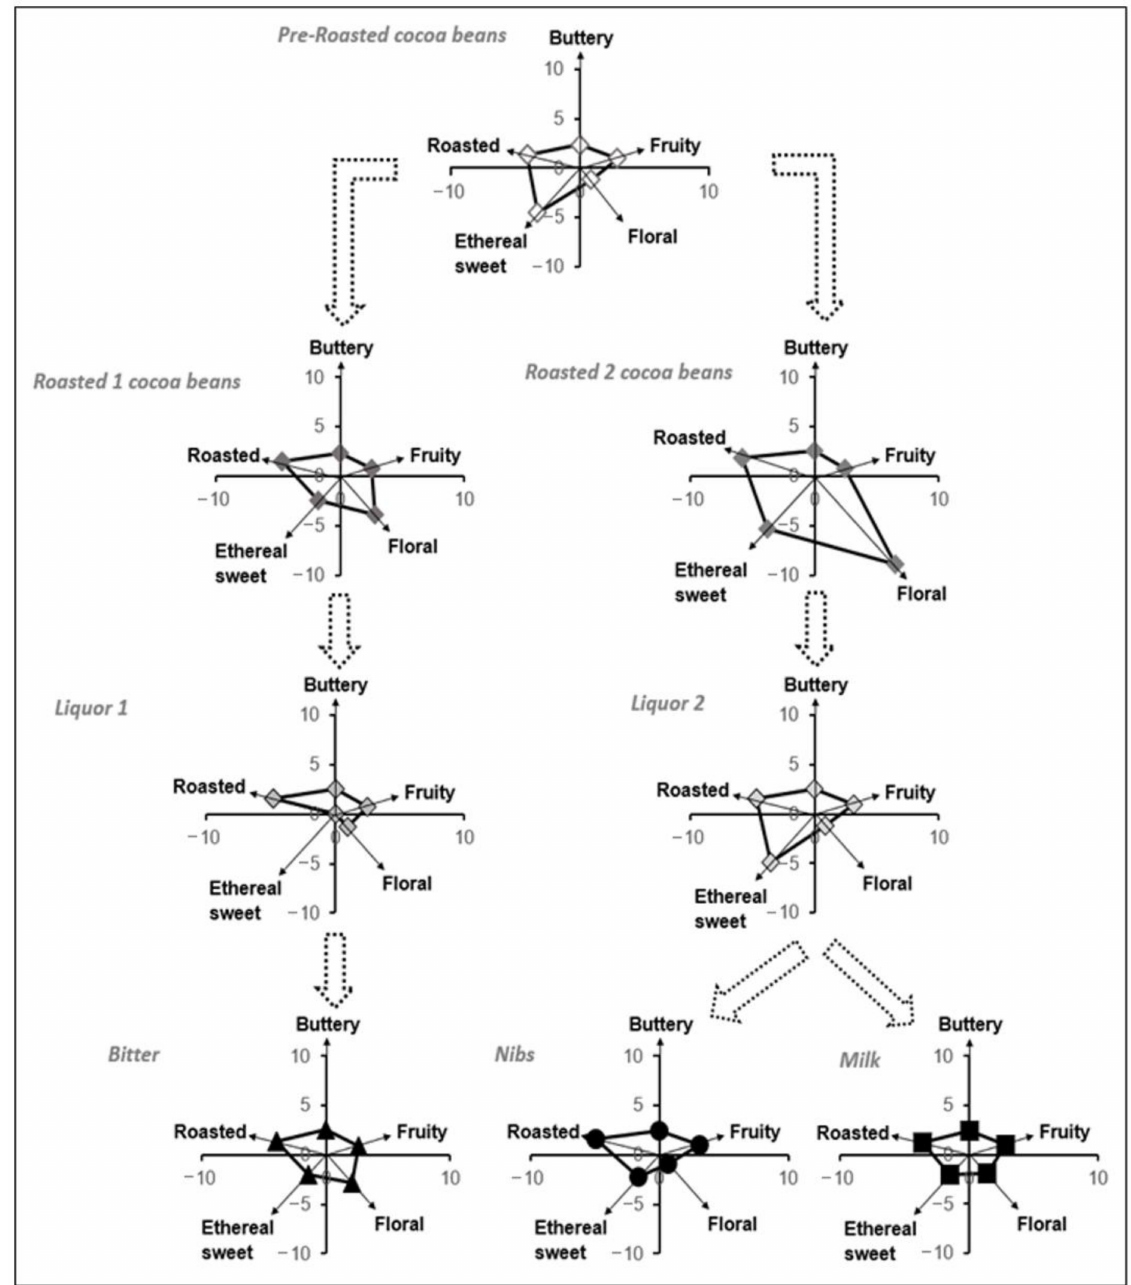
Figure 4. Flavor development during each key step of chocolate